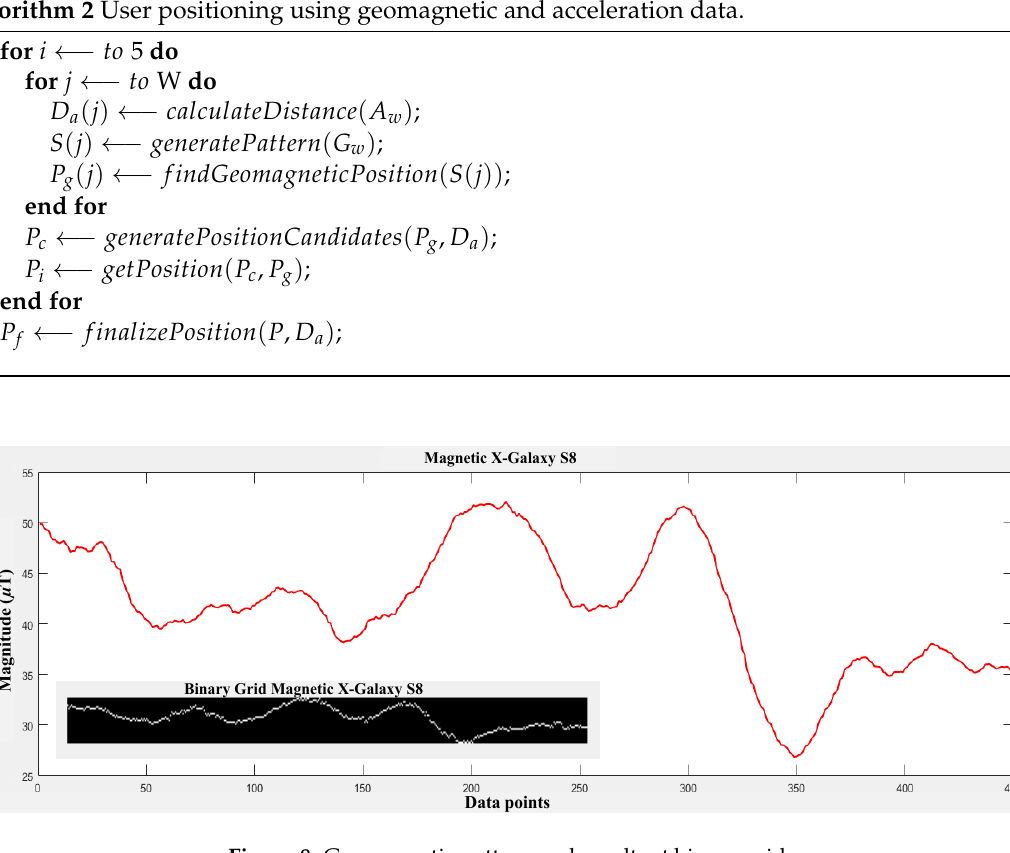
Figure 8. Geomagnetic pattern and resultant binary grid. Table 3. List of notations and their description used in the